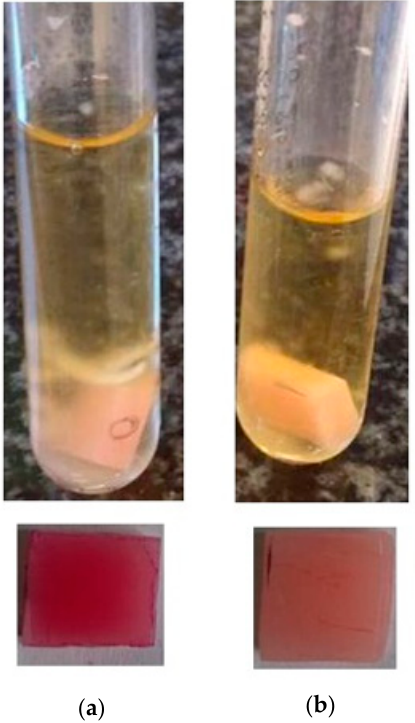
Figure 7. Analysis of the impact of composite materials: base material ( a ) and hybrid composite base + 2.5% HNT-g + 2.5% ATH-sil ( b ), against the C. albicans strain—qualitative method.